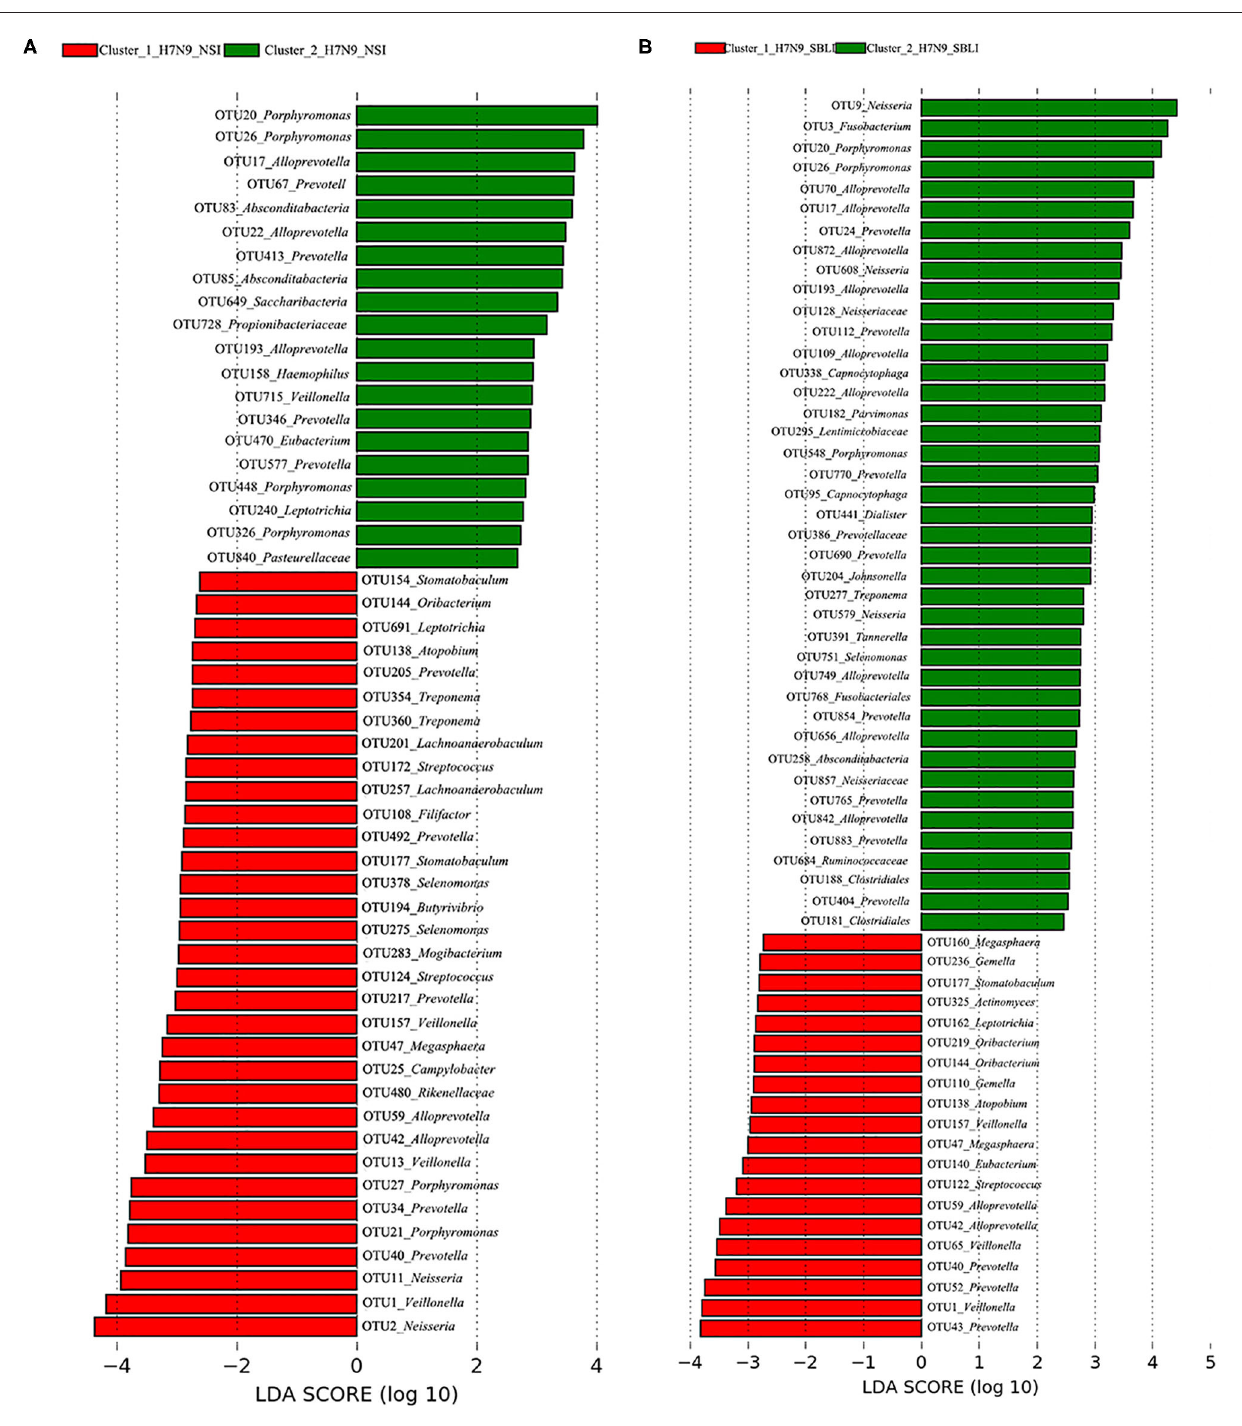
suggesting that the increased Veillonella in the OP microbiota could be a source of Veillonella in the gut of H7N9 patients with